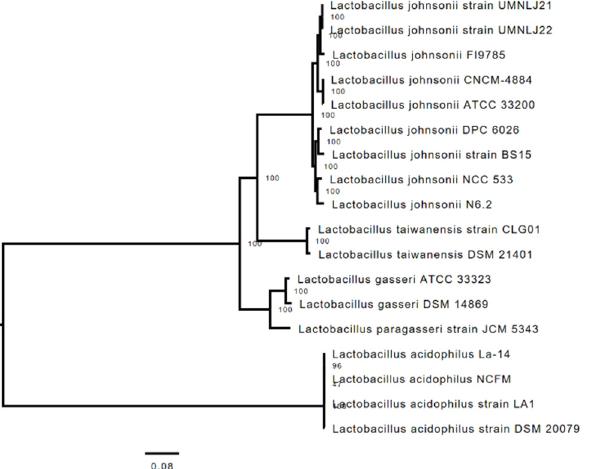
Figure 2. Phylogenetic relationship among selected lactobacilli genomes and strain CNCM I-4884. To go deeper in the molecular identification of CNCM I-4884 at the strain level, the nucleic sequences of 14 phylogenetic markers of CNCM I-4884 were compared with those of available complete genomes of L. johnsonii strains using BLASTn (Table 1). The results indicate that the phylogenetic markers of CNCM I-4884 share strong nucleic sequence similarity with those of L. johnsonii ATCC 33200 (sequence identity > 99% for all 14 phylo- genetic markers tested). Table 1. Percentage of nucleic sequence identity for phylogenetic markers of CNCM I-4884 com- pared to homologous markers in L. johnsonii and L. gasseri strains.